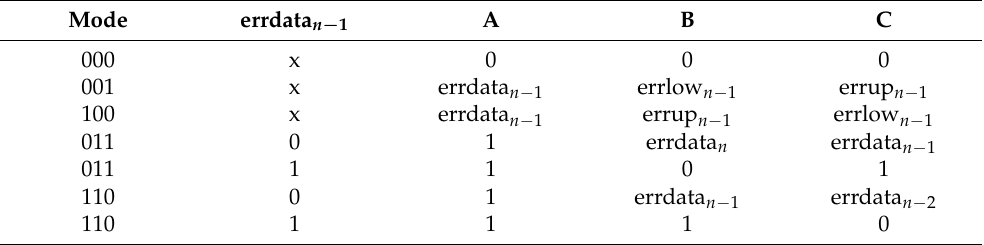
Table 3. Data Selector truth